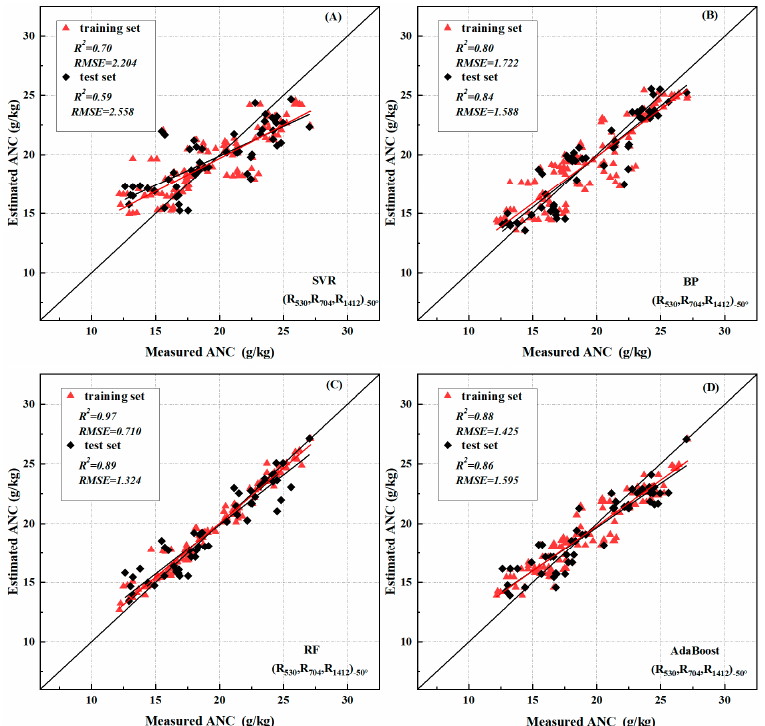
Figure 10. Machine learning modeling in the 530 nm, 704 nm, and 1412 nm bands based on spectral index AINI − 50 ◦ (n = 180, training set = 126, validation set = 54): ( A ) SVR, ( B ) BP, ( C ) RF, ( D ) AdaBoost.